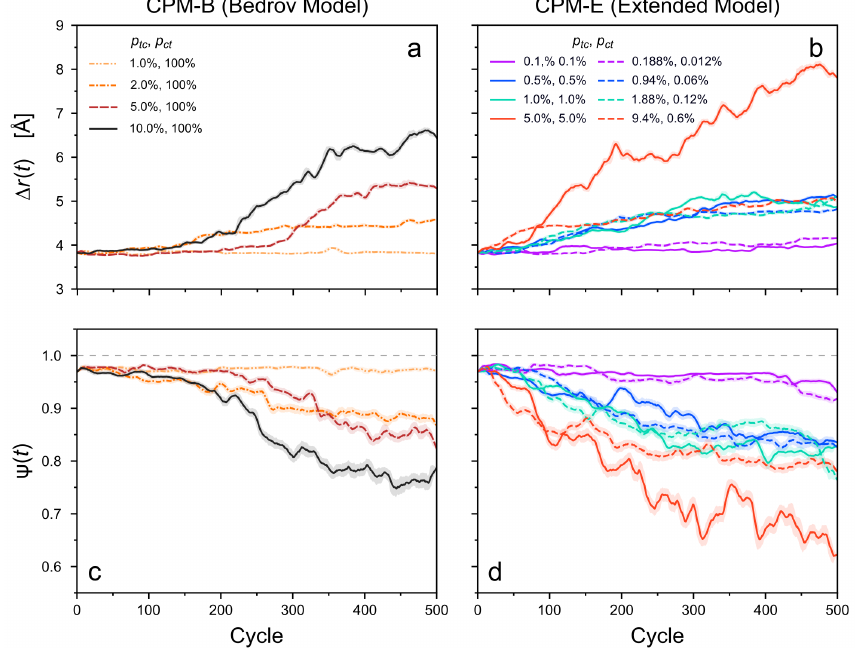
Figure 8. ( a , b ) Average pairwise COM distance between adjacent monomers, ∆ r ( t ) , and ( c , d ) average global columnar orientation order parameter of the TrisAzo cluster, Ψ ( t ) , each as a function of time. Results for the CPM-B (left-hand side) and the CPM-E (right-hand side) are shown for different switching probabilities per cycle. Each curve is smoothed via a running average (window size of 20 cycles, corresponding to 0.96ns). Shaded error bands indicate the standard deviation of the raw curve in each window. The gray dashed line indicates the maximum possible value of Ψ ( t )